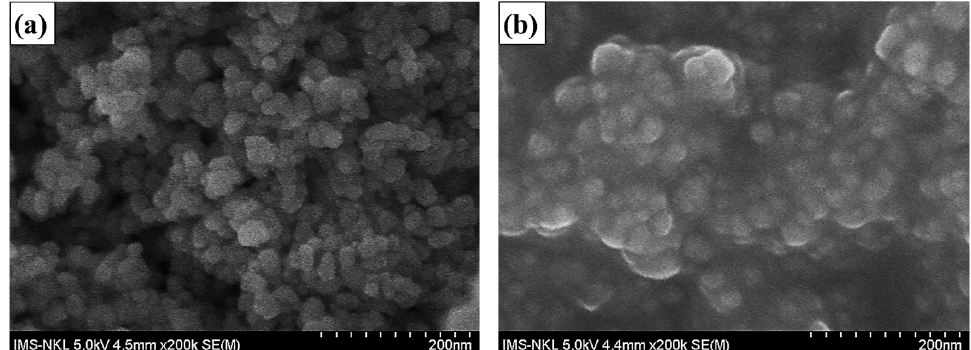
Figure 1. SEM images of the YVO 4 :Eu 3+ sample ( a ) and YVO 4 :Eu 3+ @silica-NH-GDA-IgG ( b ) samples.